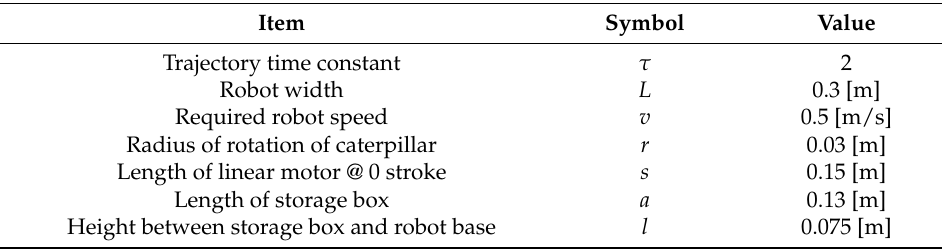
Table 2. Additional parameter value for controller design and experiment.